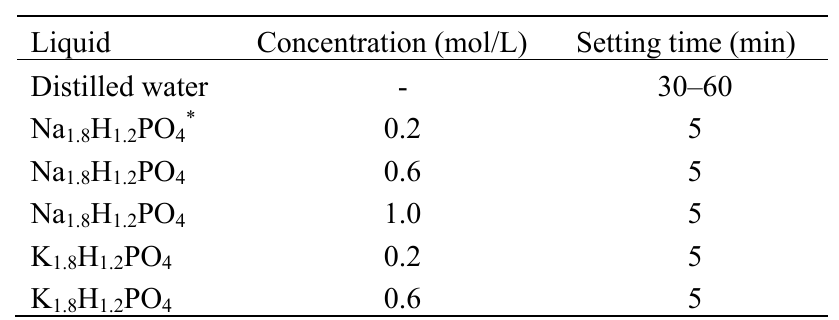
Table 3. Effects of liquid phase on the setting time of calcium phosphate cement consisting of tetracalcium phosphate and dicalcium phosphate anhydrous